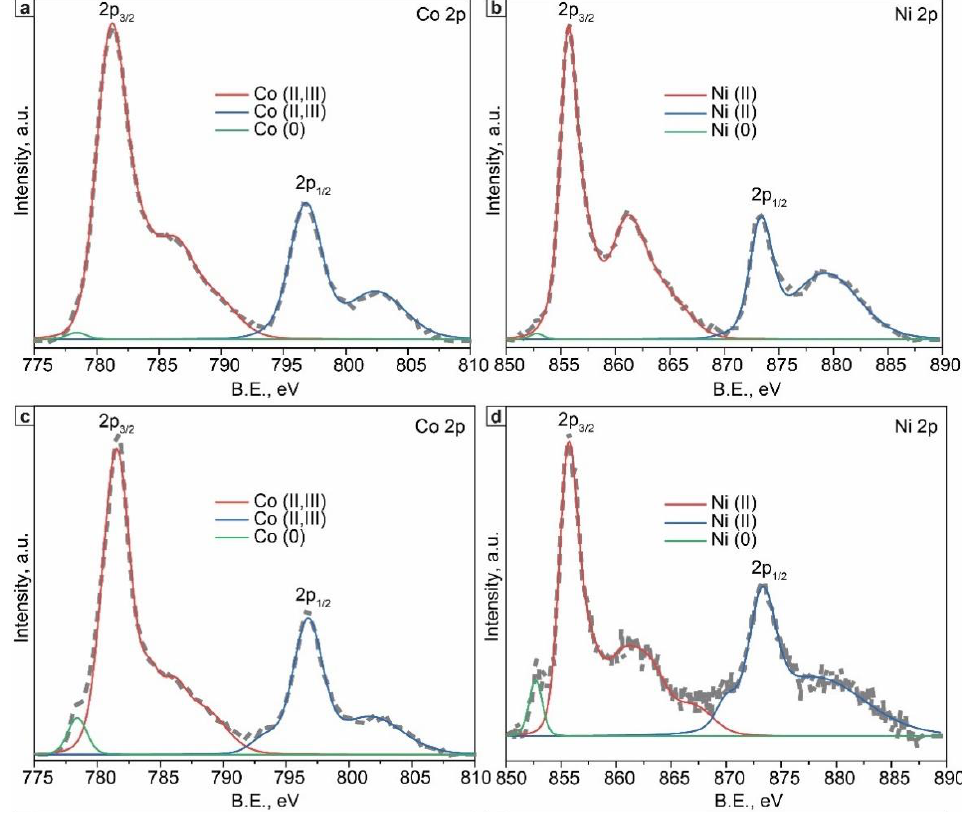
Figure 3. High-resolution XPS spectra of the as-synthesized ( a ) Co, ( b ) Ni, ( c , d ) Co 3 Ni, ( e , f ) CoNi, and ( g , h ) CoNi 3 catalysts.